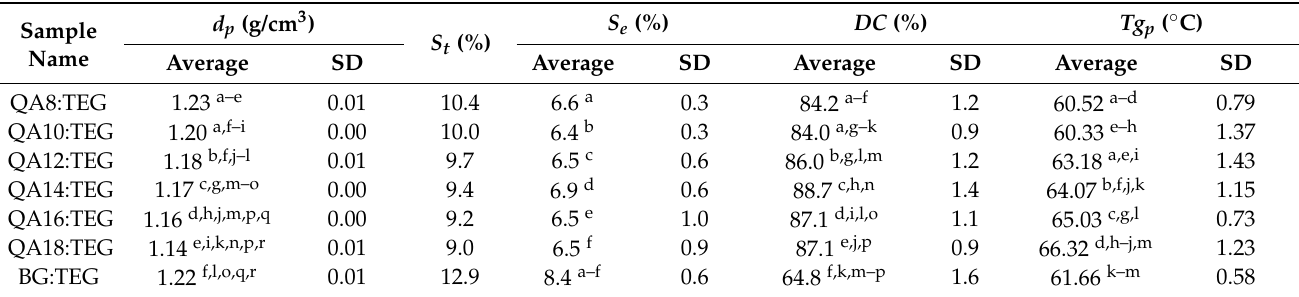
Table 3. Physicochemical properties of studied copolymers: density ( d p ), theoretical polymerization shrinkage ( S t ), experimental polymerization shrinkage ( S e ), degree of conversion ( DC ) and glass transition temperature ( Tg p ). Lower case letters indicate statistically significant differences ( p ≤ 0.05) with a column (non-parametric Wilcoxon test).